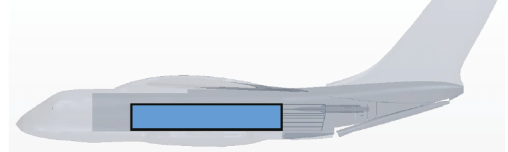
Figure 6: Computational geometry.